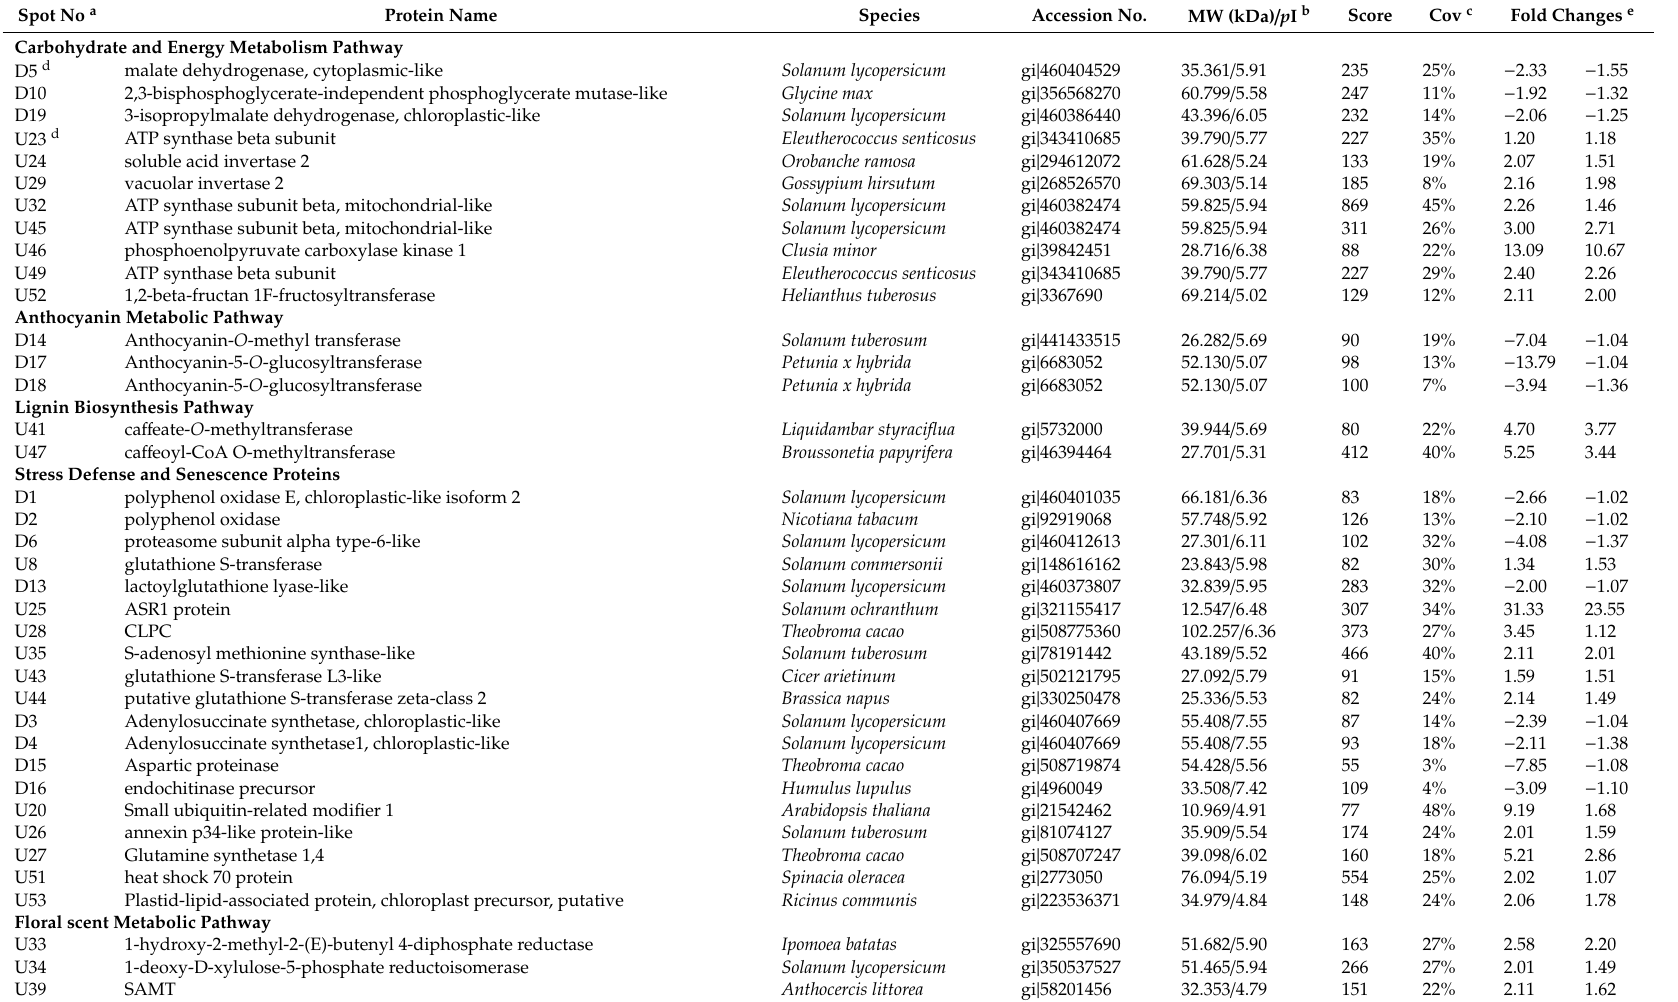
Table 1. Identification of proteins from B. acuminata petals using MALDI-TOF /